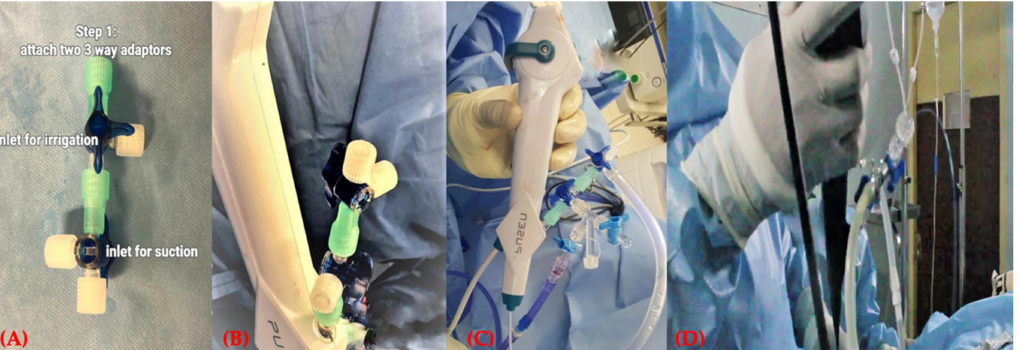
Figure 1. Assembling the DISS device. ( A ) Adaptor. ( B , C ) Adaptor attached to the scope. ( D ) Han- dling the scope with the adaptor